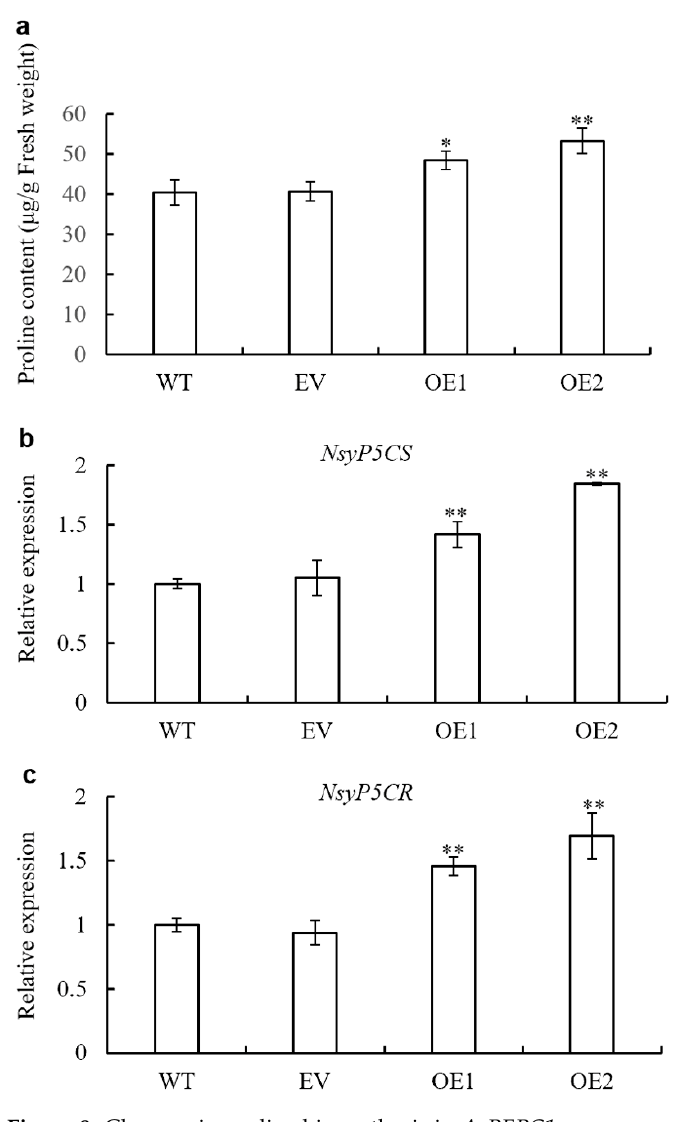
Figure 8. Changes in proline biosynthesis in AaPEPC1 -overexpressing tobacco plants. ( a ) Proline content in the leaves of transgenic plants expressing AaPEPC1 (OE1 and OE2) as well as empty vector (EV), and wild-type plants (WT). ( b ) and ( c ) Relative expression level of the proline biosynthesis genes pyrroline-5-carboxylate synthase (P5CS) and pyrroline-5-carboxylate reductase (P5CR) in the AaPEPC1 -overexpressing tobacco plants. Values represent means ± SD (n = 3). * and ** indicate significant difference from that of WT at P < 0.05 and P < 0.01, respectively, by one-way ANOVA analysis with post-hoc Tukey HSD.